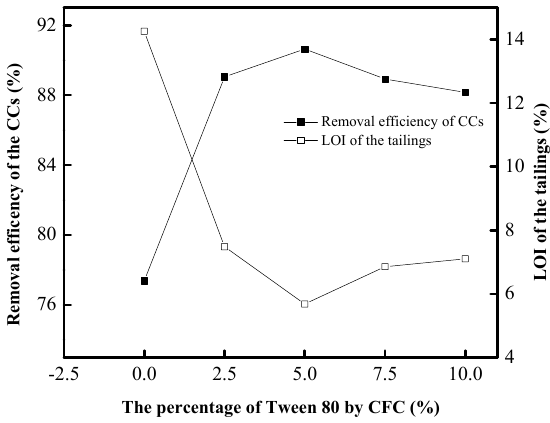
Figure 7. Effect of Tween 80 on decarburization by CFC: kerosene = 3 g/kg·ash, MIBC = 0.1 g/kg·ash, slurry concentration = 100 g/L, and pump speed = 2000 r/min.